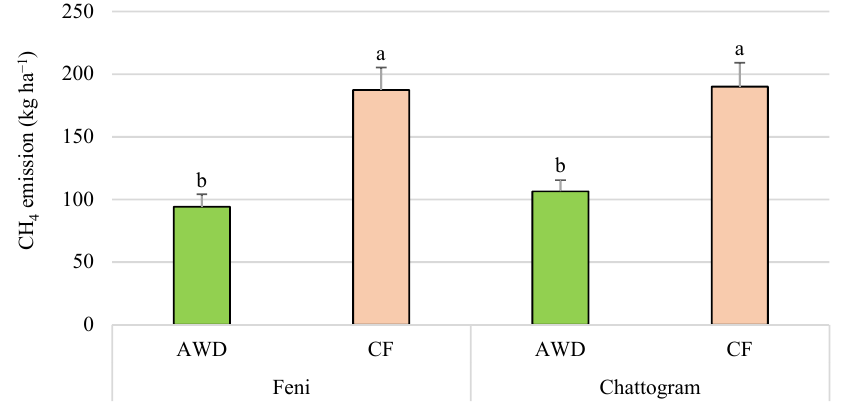
Figure 4. Effect of AWD and CF irrigation methods on the CH 4 emission from the paddy field at Feni and Chattogram districts. Means with different letters indicate significant differences at the 5% level.